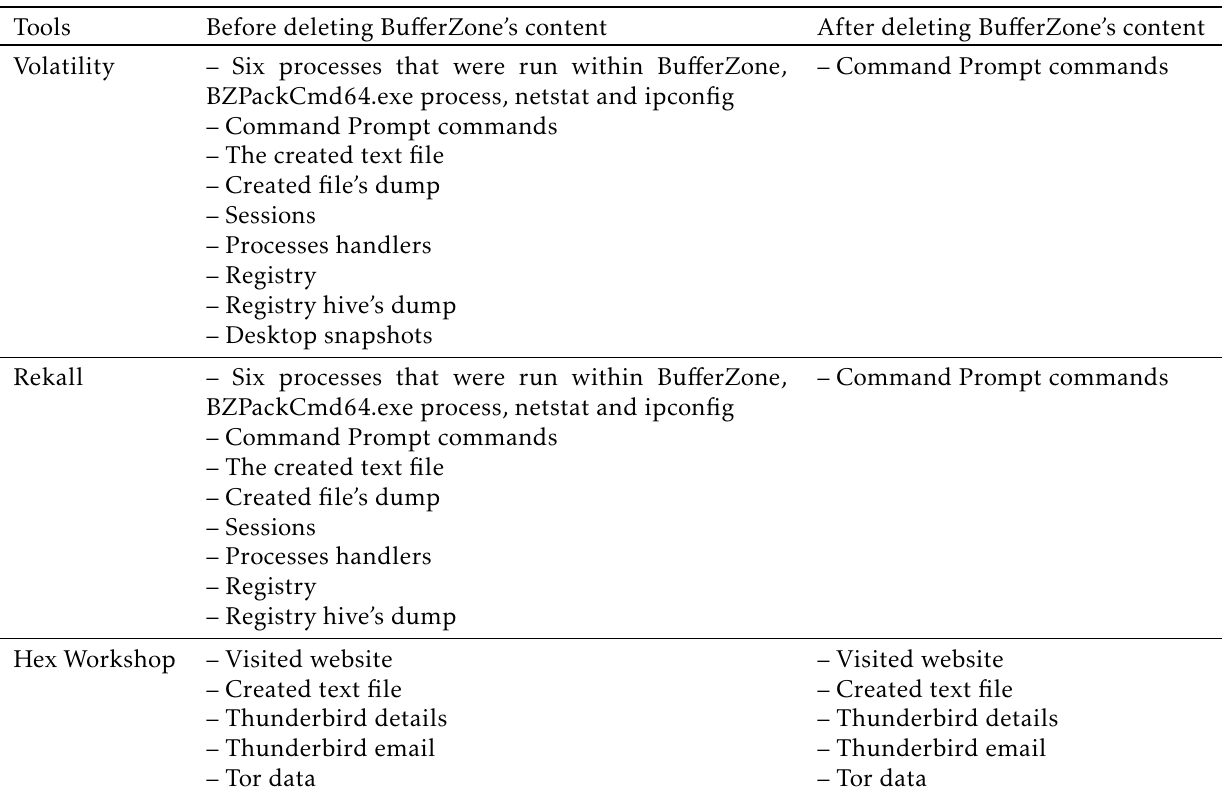
Table 10. Analysis results of the BufferZone